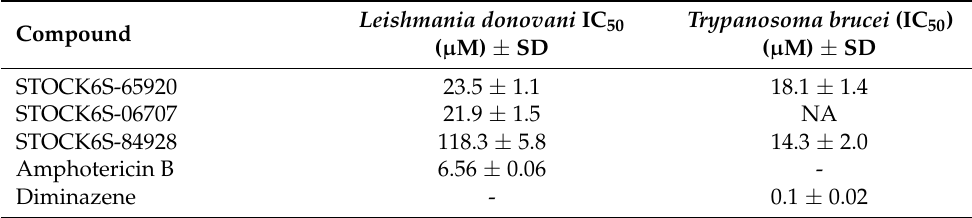
Figure 7. MM/PBSA computation of per-residue energy decomposition for the Ld SMT-STOCK6S- 06707 complex. Table 6. Results from the in vitro studies of the selected hit compounds against the promastigotes of Leishmania donovani and Trypanosoma brucei